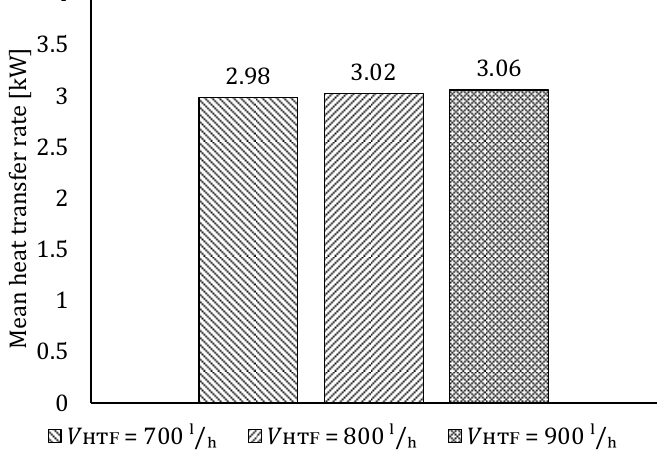
Figure 21. Comparison of mean heat transfer rate during melting obtained numerically for different HTF flow rates, HTF inlet temperature 40 °C and initial PCM temperature 15 °C.